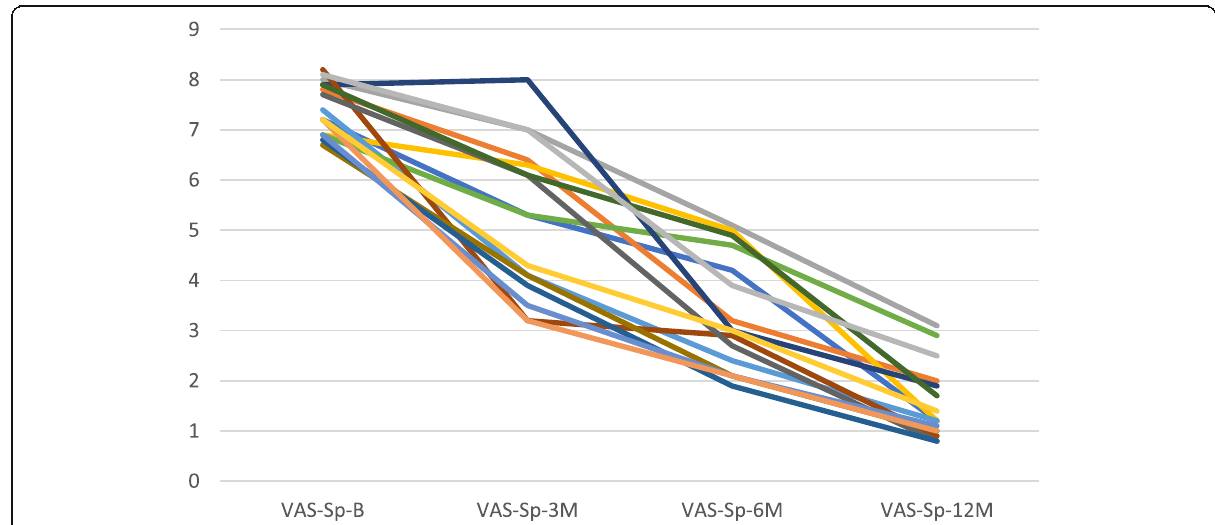
Fig. 4 Individual knee Visual analogue scale sports (VAS-Sp) at baseline (VAS-Sp-B), 3 months (VAS-Sp-3M), 6 months (VAS-Sp-6M) and 12 months (VAS-Sp-12